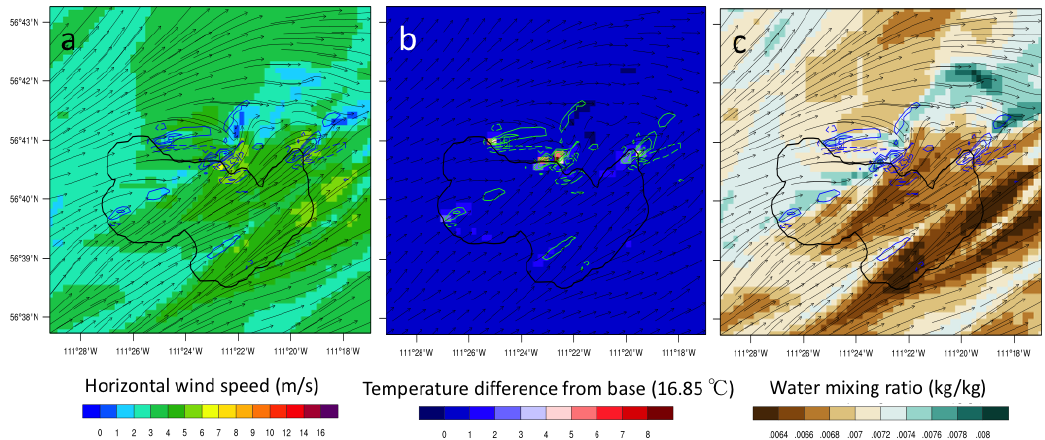
Figure 8. Horizontal snap shot at model level 1 (200–500 m above ground) on May 3, 2016 00 UTC of ( a ) wind speed and direction, ( b ) temperature gradient and wind direction and ( c ) mixing ratio and wind direction. The blue contour lines represent the vertical velocities. The dashed contours represent downdrafts, and solid line contours represent updrafts. The black line illustrates the fire perimeter.